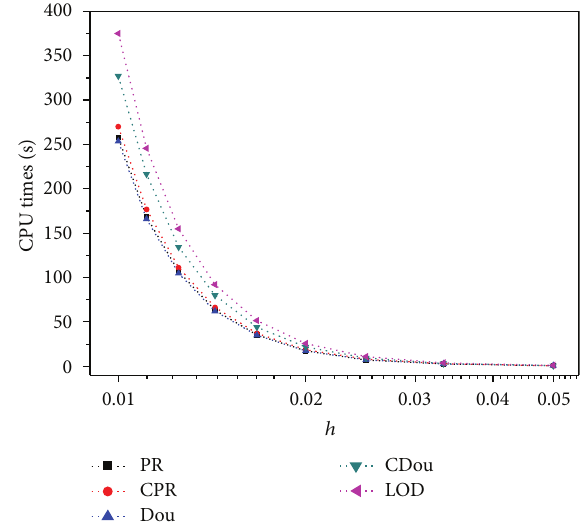
Figure 4: The CPU time of all schemes for various grid sizes when Δ𝑡 = ℎ 2